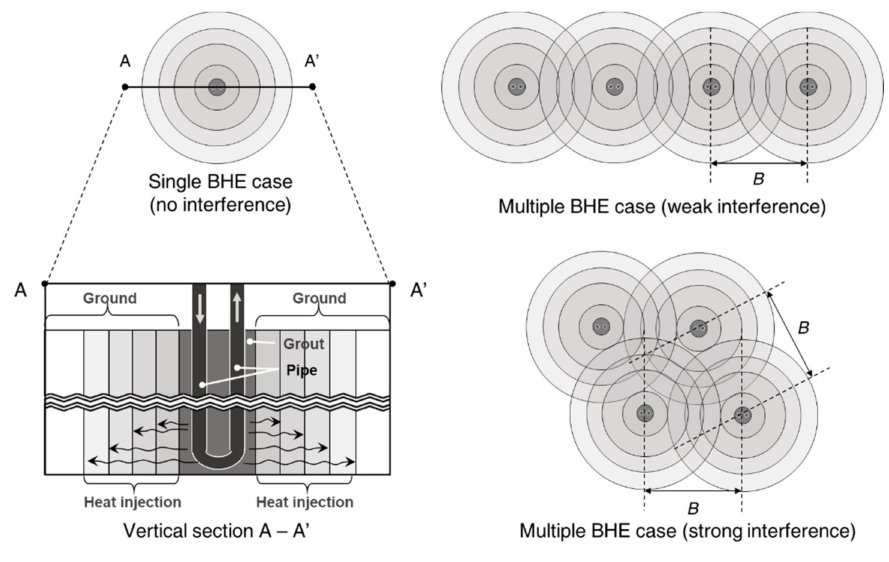
Figure 2. Heat interference effects according to BHE